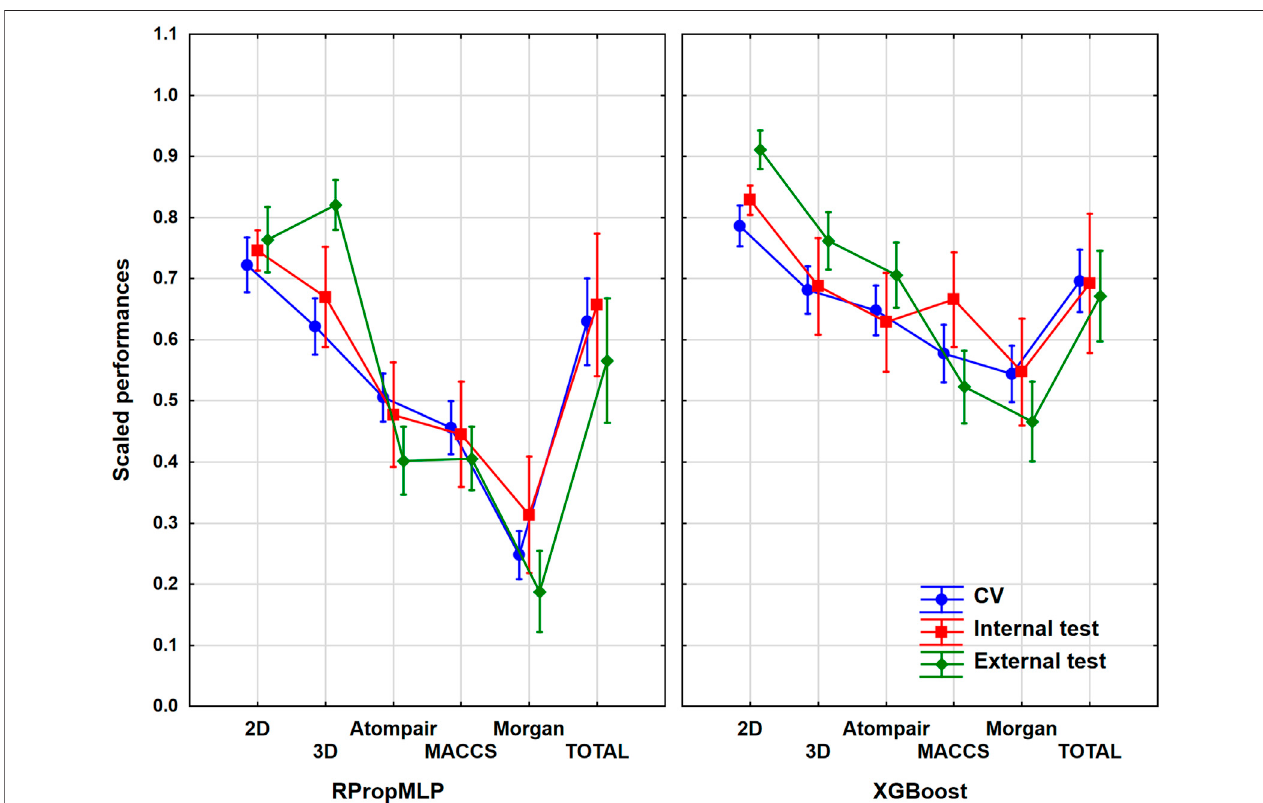
FIGURE 7 | Scaled performances of the models in the case of P-glycoprotein dataset based on the molecular descriptor types and machine learning algorithms. The 18 performance parameters were range-scaled between 0 and 1 and averaged across all models with the given descriptor types/ML algorithms. The result of CV is markedwithblue,theinternaltestresultismarkedwithred,andtheexternaltestismarkedwithgreen.Themeanofthescaledperformanceparametersisplottedineach case with the 95% con fi dence intervals.